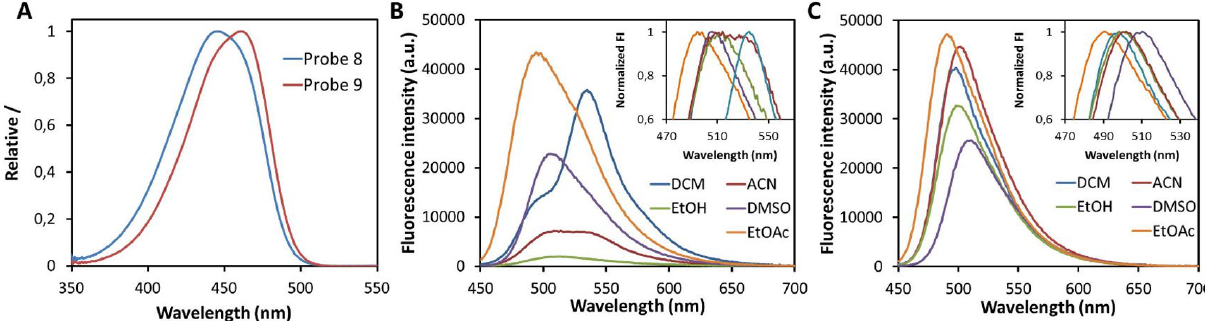
Figure 2. (A) Normalized absorption spectra of probes 8 (blue) and 9 (red). Absorption spectra were recorded with 8∙10 –6 M solutions of each in ethanol. (B and C) Emission spectra for probes 8 (B) and 9 (C) in different solvents at concentrations of 5∙10 –7 M (λ ex = 420 nm). Inset: normalized emission spectra for probes 8 (B) and 9 (C) in different